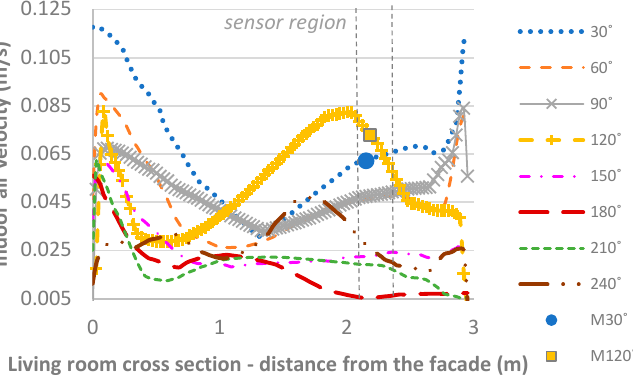
Figure 11. Predicted indoor air velocities (m/s) at 100 points along a measuring line (transversal) with measured values at θ = 30° and θ = 120° wind directions.